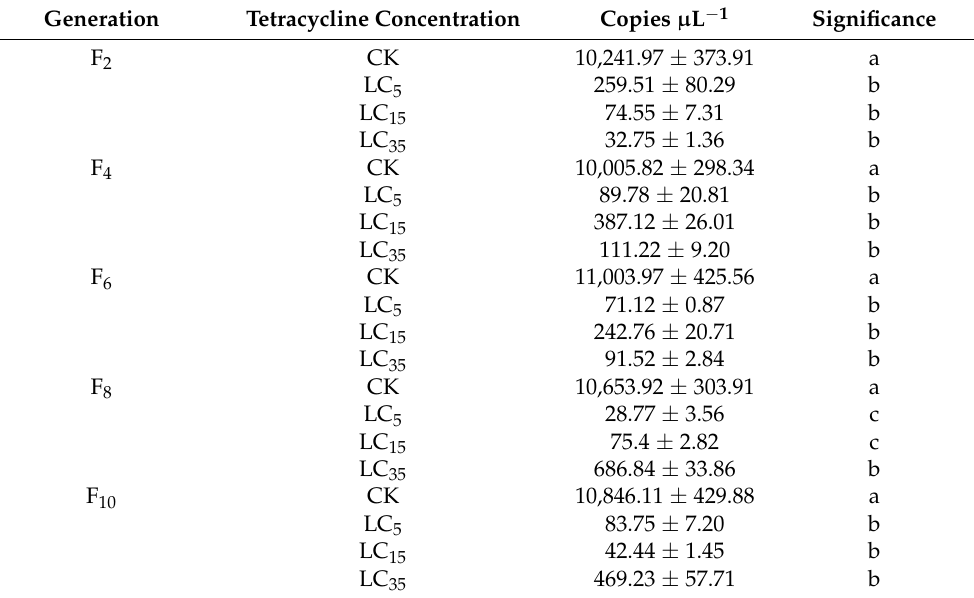
Table 4. Dynamics of Wolbachia titer in T. pretiosum treated with sublethal concentrations of tetracy- cline for ten